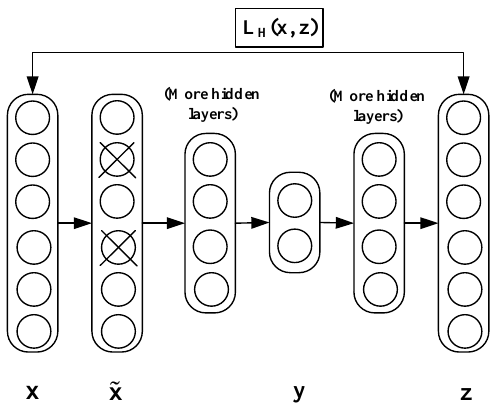
Figure 2. The schematic structure of the DAE.